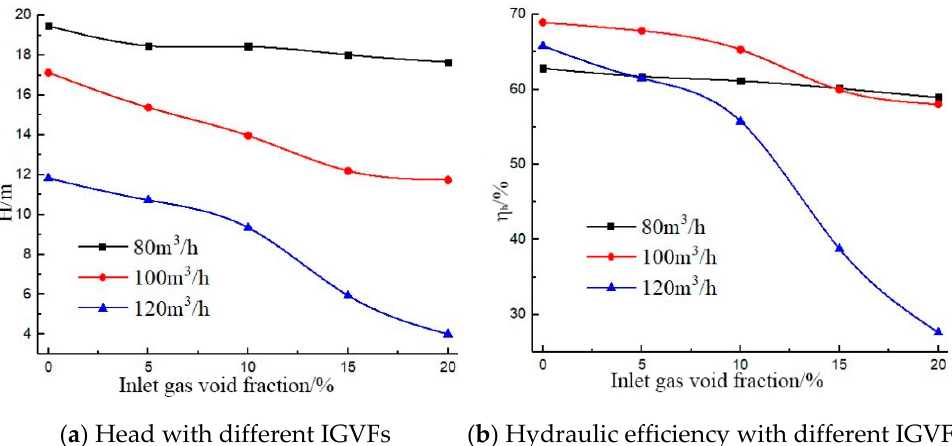
Figure 8. External characteristic of the multiphase pump under various circumstances.